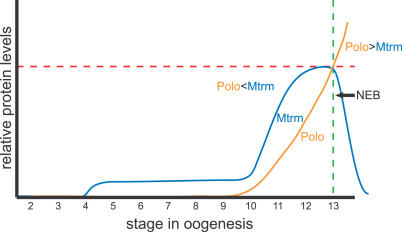
A Model for the Control of NEB by Mtrm-Induced Inhibition of PoloAccording to this model, in wild-type Drosophila oocytes, the excess of Mtrm inhibits those Polo proteins that are deposited in the oocyte during stages 11 to 12. However, by stage 13, an excess of Polo exceeds the available amount of inhibitory Mtrm proteins. This unencumbered Polo then serves to activate Cdc25, initiating the chain of events that lead to NEB and the initiation of prometaphase. In the absence of a sufficient amount of Mtrm, an excess of functional Polo causes the precocious activation of Cdc25 and thus an early G2/M transition. Based on this model, one can visualize that decreasing the dose of Mtrm or increasing the dosage of Polo will hasten NEB, while simultaneous reduction in the level of both proteins will normalize the timing of NEB.